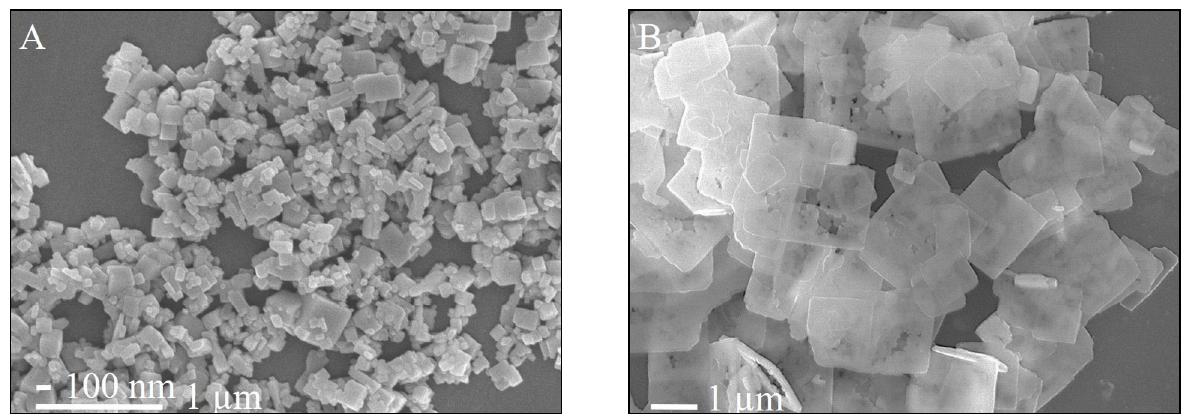
Figure 5: SEM micrographs of SrTiO 3 particles obtained from the topochemical conversion of different Bi 4 Ti 3 O 12 plate-like particles under the same hydrothermal reaction conditions (Sr:Ti molar ratio 3:1, 4-M NaOH, 200 °C for 12 hours). The SrTiO 3 particles A were prepared from the BIT2 template and the SrTiO 3 particles B were prepared from the BIT8